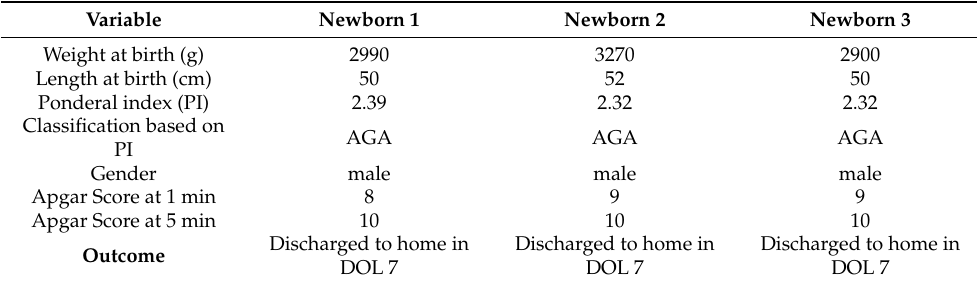
Table 3. Clinical features of